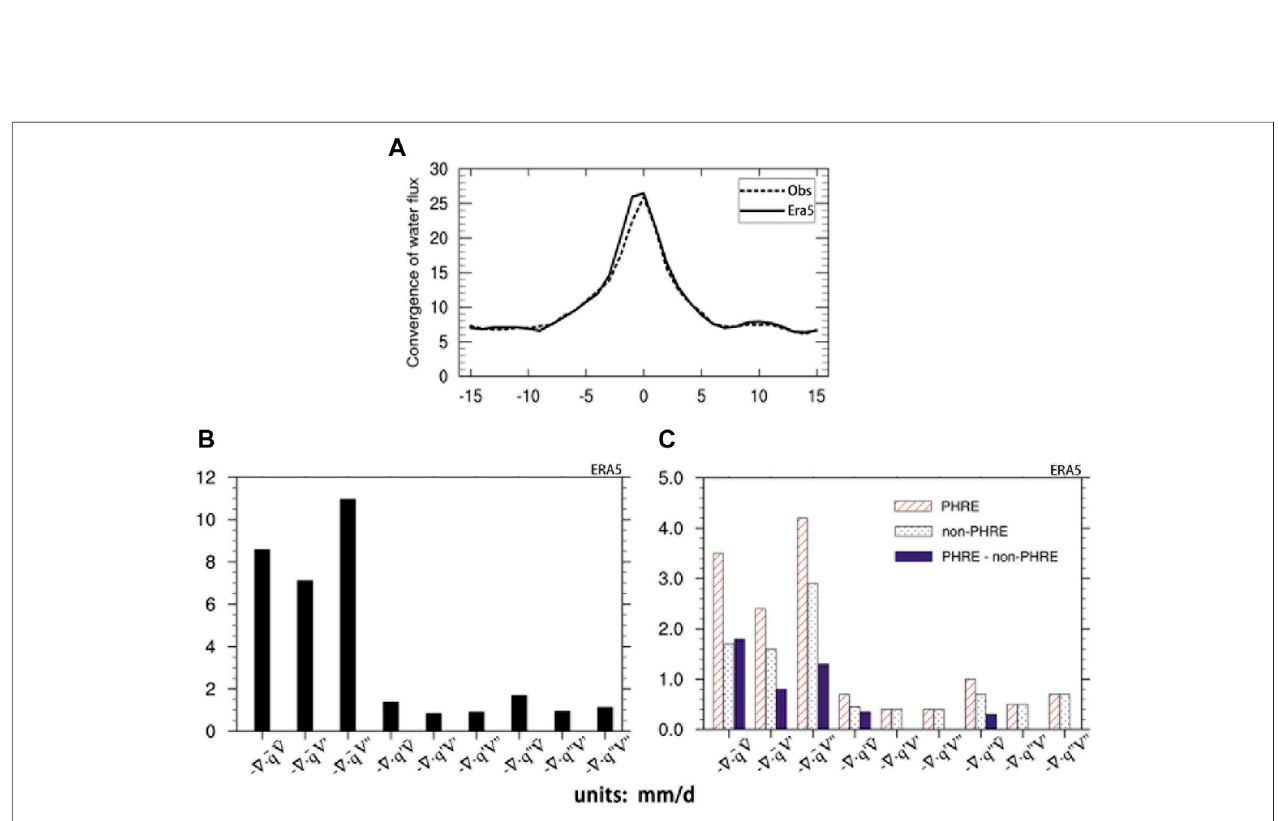
FIGURE 4 | (A) The precipitation totals calculated by the vertical integral of the vapor fl ux convergence and observed precipitation (dashed line) (units: mm/d) averagedovertheMLYRduringPHREswithdurationsof − 15to15 days,forwhichday0representsallPHREdays (B) Thenineitemscalculatedbytheverticalintegralof thevapor fl uxconvergenceduringPHREs(units:mm/d) (C) thenineitemscalculatedinPHREyears(redslant),non-PHREyears(bluedots),andthedifferencesbetween these years (solid blue bars) (units: mm/d). The horizontal axes in Figures 4B, C show the interactions between wind and speci fi chumidity at different time scales, as shown in Eqs 2 , 3 , and 4